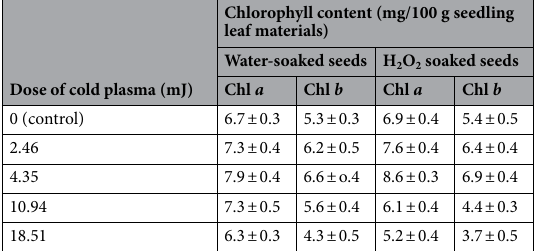
Dose of cold plasma